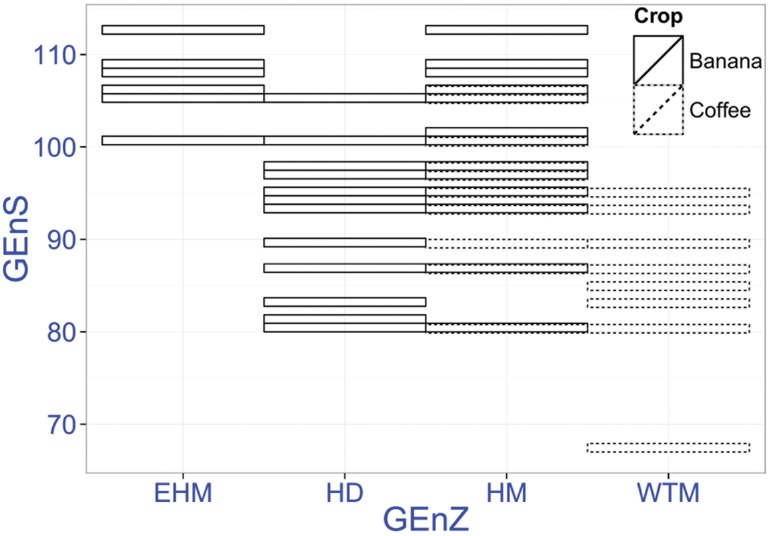
Bioclimatic strata (GEnS), within the major bioclimatic zones (GEnZ) at the cultivation areas of banana and coffee in Nepal.Overlap of color in the strata represents occurrence of both crops (EHM—extremely hot and moist; HD—hot and dry; HM—hot and mesic; WTM—warm temperate and mesic). GEnS is represented numerically (nominally arranged along an increasing average annual temperature gradient) in a range from 1–125. Banana and coffee plantations were found between strata 66–113.